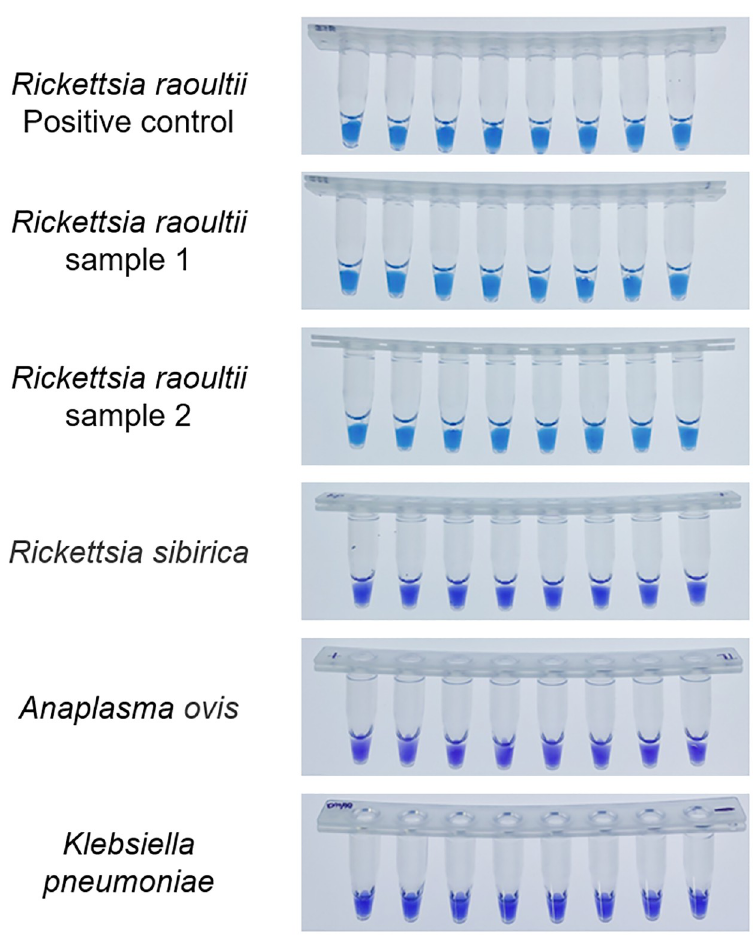
Fig 6. Colorimetric RO-CDA assay using HNB. Line 1, positive controls (10 6 copies of templates); Line 2 and Line 3, samples extracted from R . raoultii ; Line 4, samples extracted from Rickettsia sibirica ; Line 5, samples extracted from Anaplasma ovis ; Line 6, samples extracted from Klebsiella pneumoniae . PC, positive reaction with the template. Due to the limited space of the manuscript, other samples are not displayed.